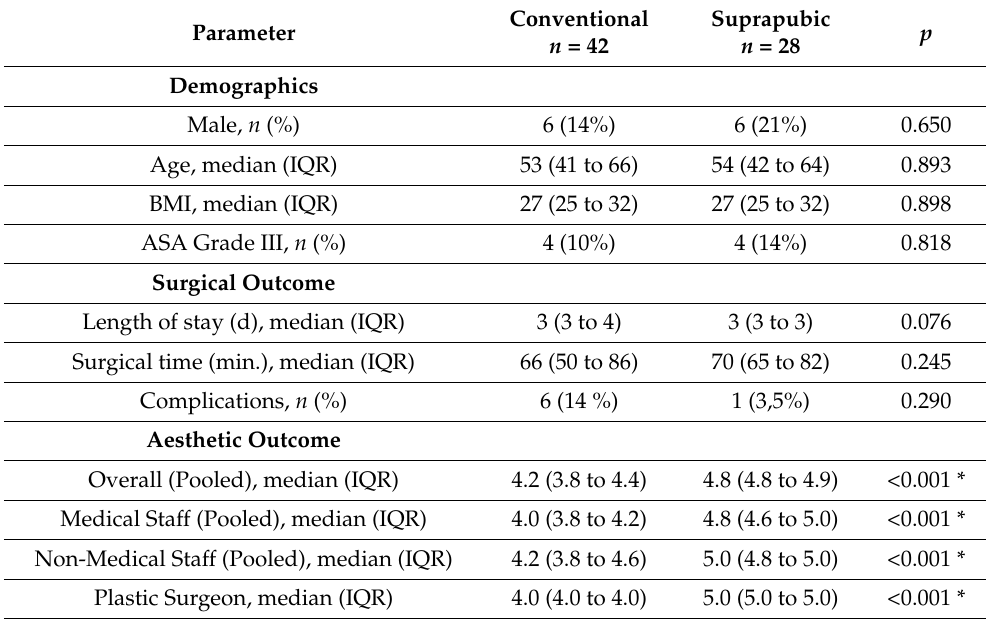
Table 1. Intergroup comparison of baseline demographics and clinical outcomes among the conven- tional and suprapubic laparoscopic cholecystectomy